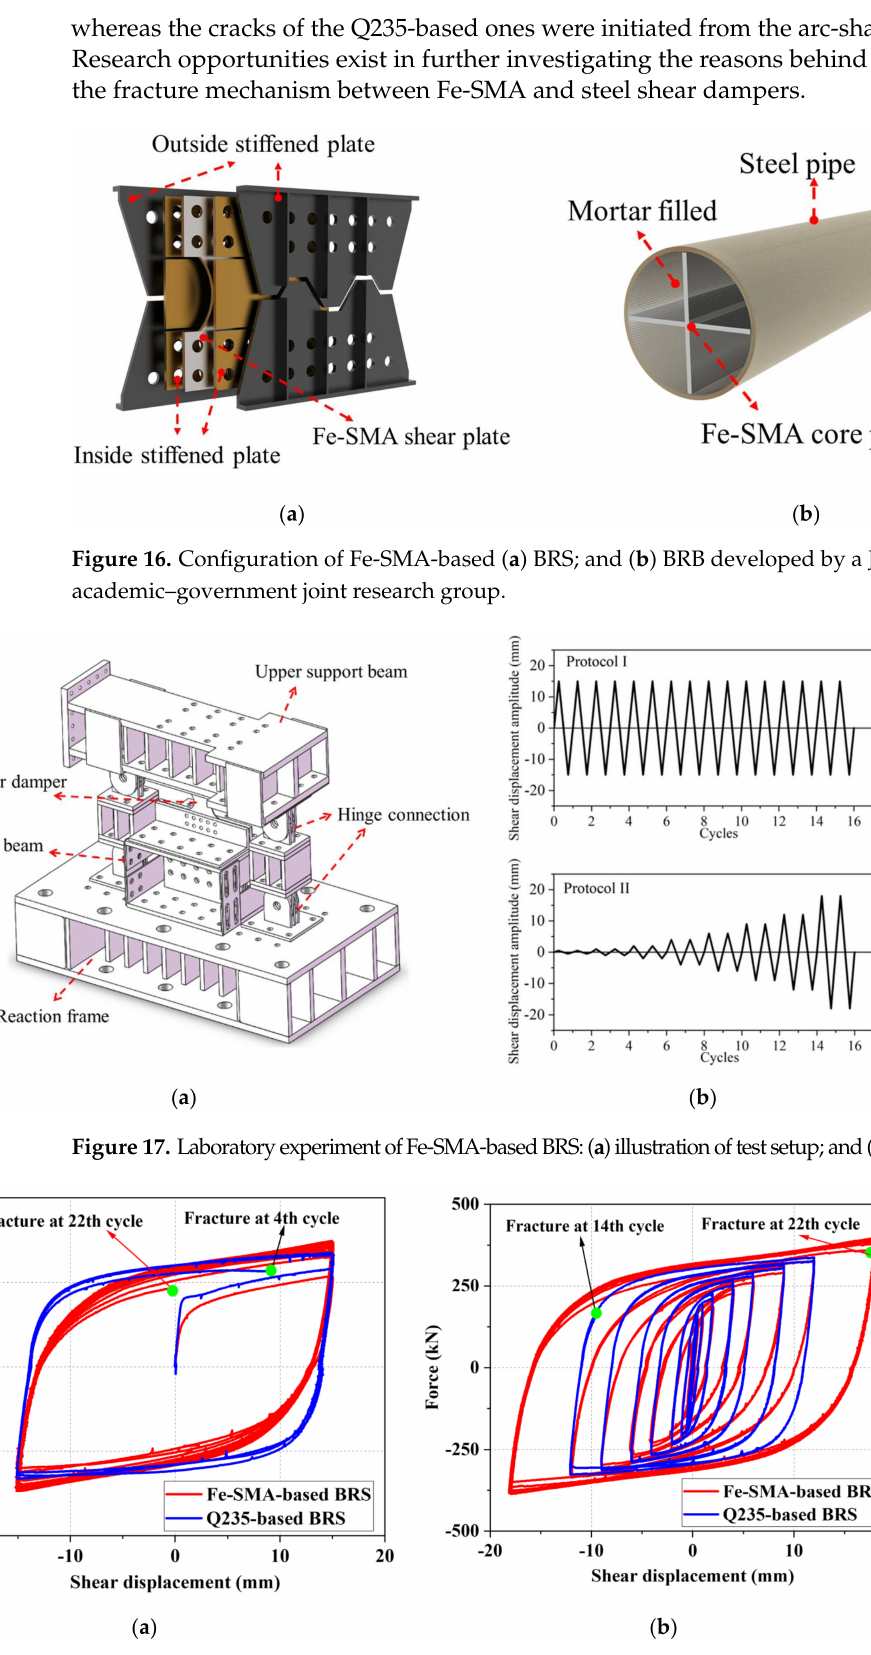
Figure 18. Hysteretic behavior for Fe-SMA- and Q235-based BRS under: ( a ) Protocol ‘I’; and ( b ) Protocol